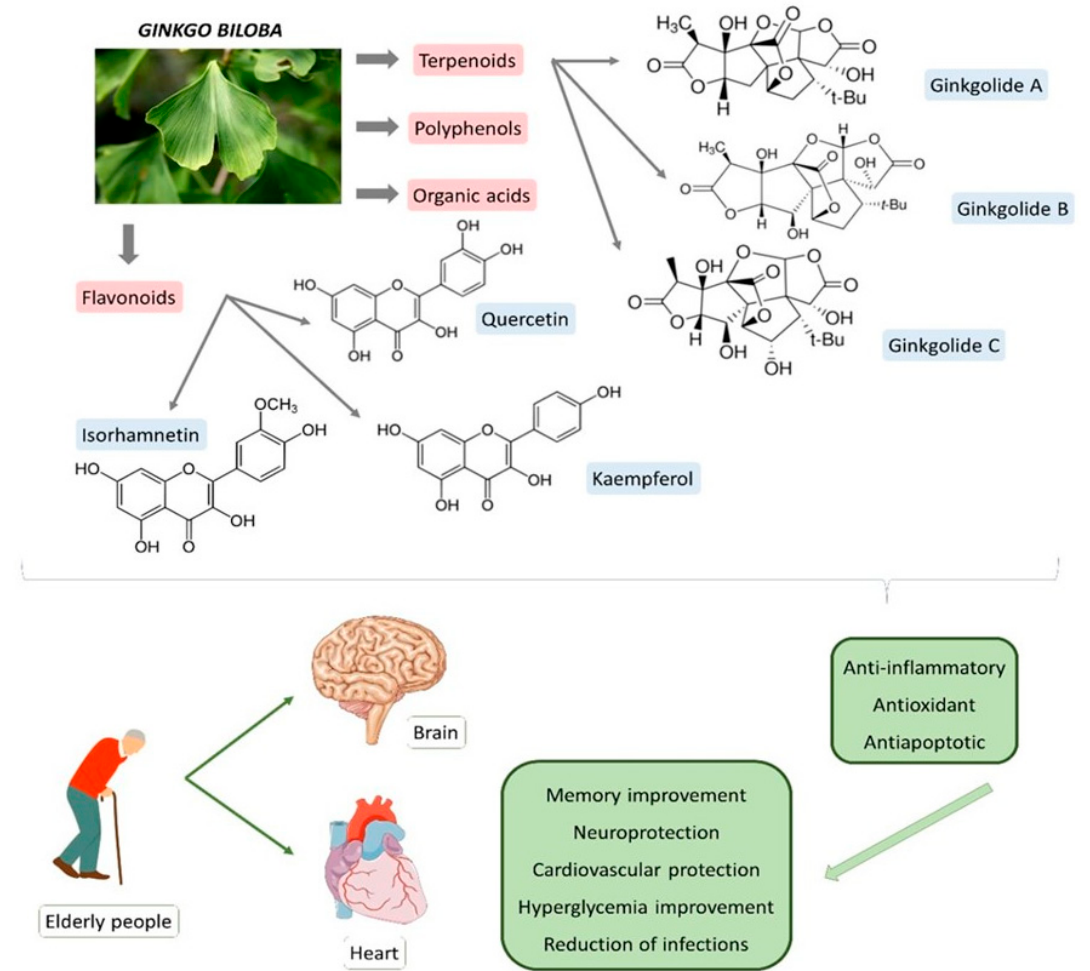
Figure 1. Primary bioactive compounds of Ginkgo biloba and its effects.